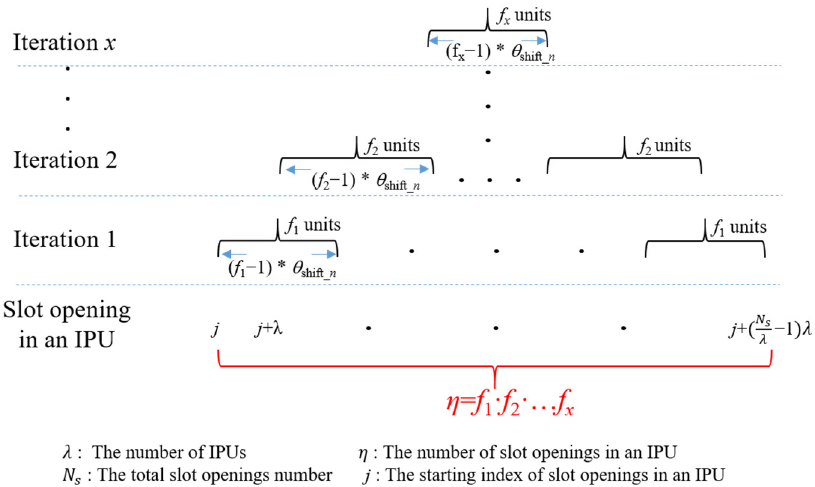
Figure 3. The iteration process of cogging torque harmonic cancellation within an IPU.